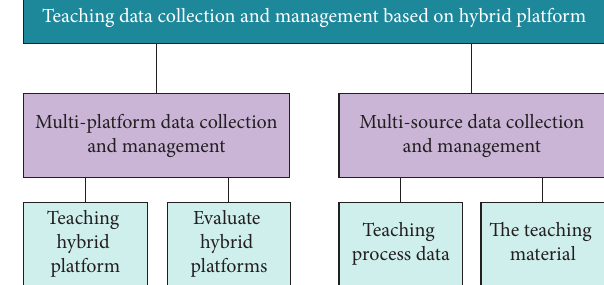
Figure 7: Overall flow chart.